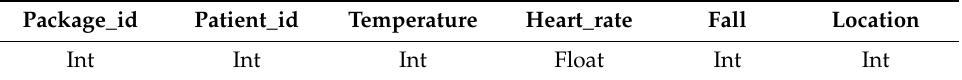
Table 3. Continuous sampling package.